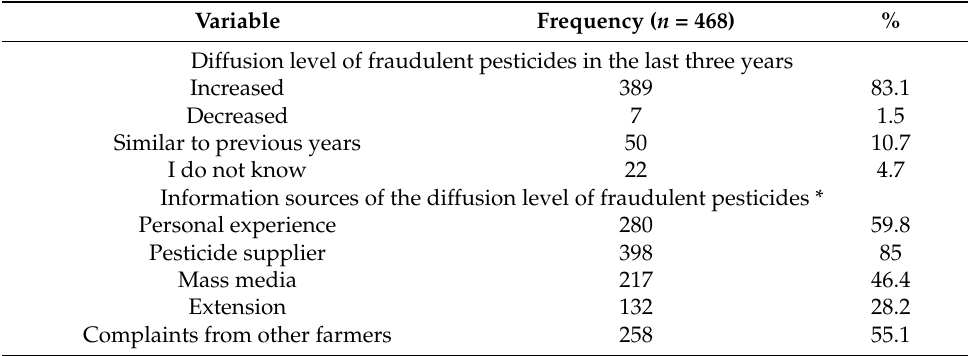
Table 4. The diffusion level of fraudulent pesticides from the farmers’